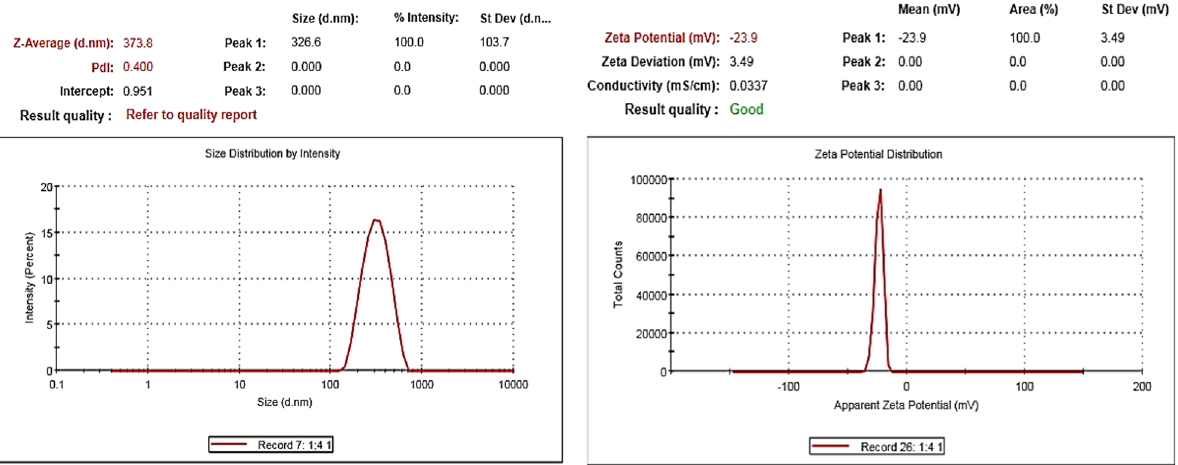
Fig. 4 Representative particle size and zeta potential graphs of DTLNS4 obtained during